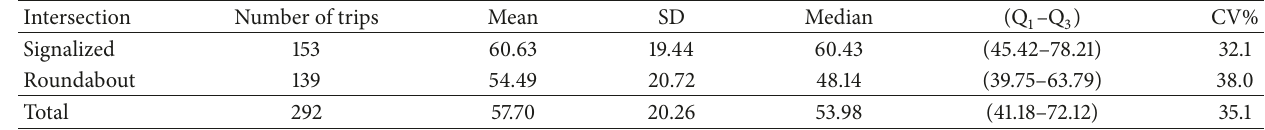
Table 8: Descriptive statistics for CO 2 emissions (g) by intersection type (traffic condition = peak).